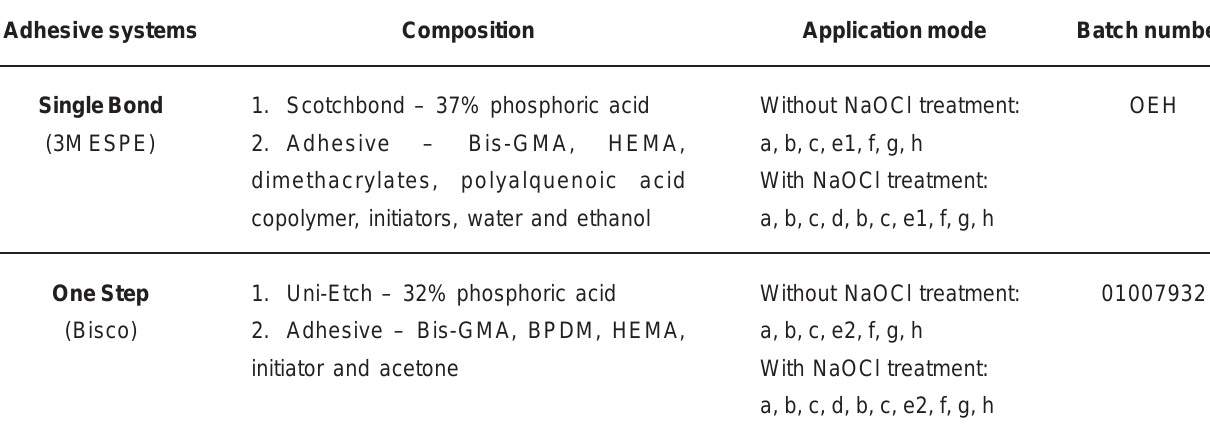
a – acid-etch (15s); b – rinse (15s); c – air-dry (30s); d – application of 10% sodium hypochlorite for 60s; e1 - dentin rewetted with 1.5ml of water; e2- dentin rewetted with 3.5ml of water; f – two coats of adhesive systems, brushed for 10s each; g – air- dry for 10s at 20 cm; h – light-cure (10s - 600 mW/cm 2